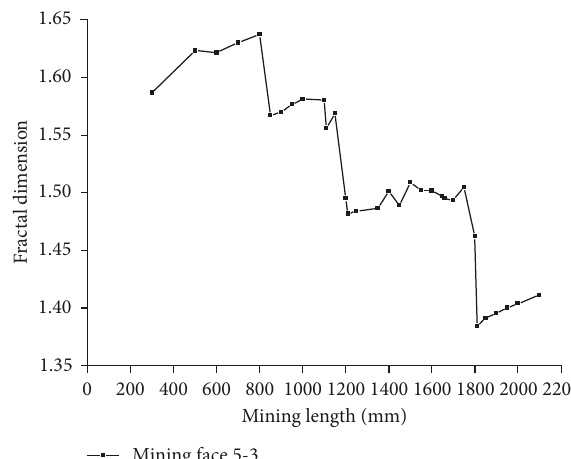
Figure 6: Evolution of the fractal dimension of fracture network with mining length.